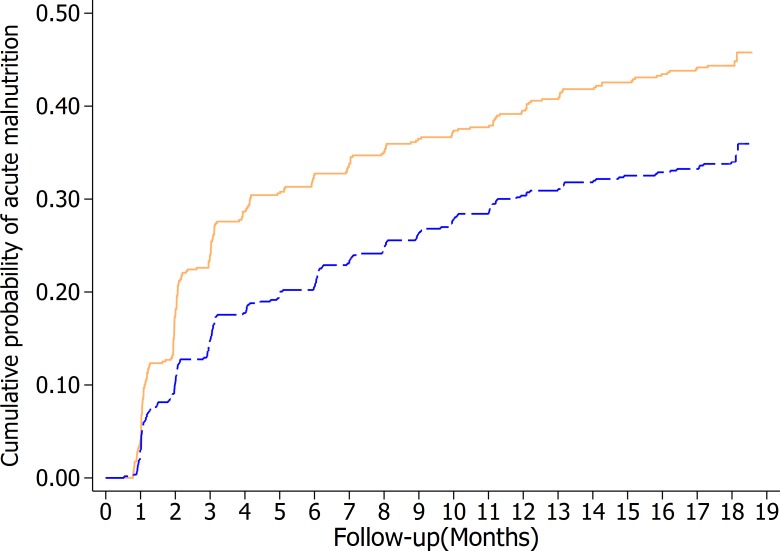
Kaplan–Meier failure plot showing the cumulative probability of child AM by study arm using the longitudinal study data (n = 567 children in the comparison arm contributing 535 child-years of follow-up; n = 565 in the intervention arm contributing 604 child-years of follow-up).The blue dashed line represents results from the intervention arm, and the orange solid line represents results from the comparison arm. AM, acute malnutrition.